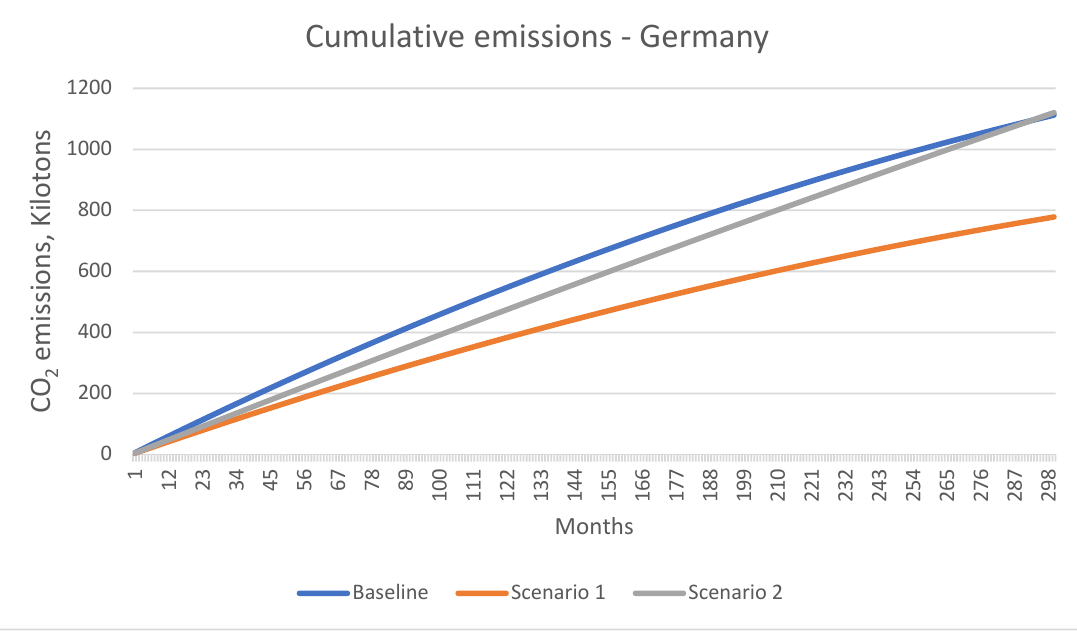
Figure 11. Comparison of emissions through electricity consumption under different scenarios in a reference cement plant in DE.